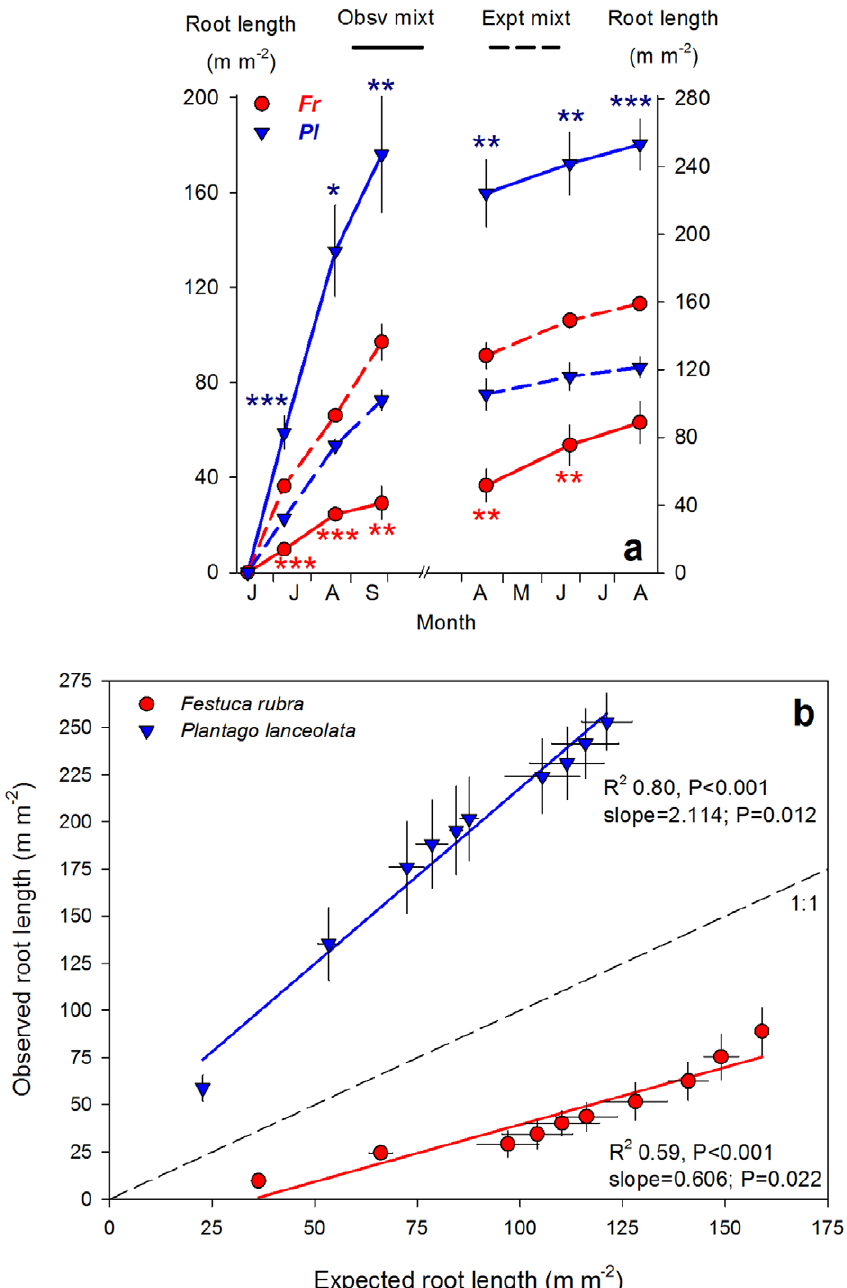
Figure 4. Root growth observed through minirhizotron tubes. ( a ) Root length production over time (m m 2 2 image) of Festuca rubra ( Fr ) and Plantago lanceolata ( Pl ) in mixtures, obtained from minirhizotron observations at 10 cm depth. Solid lines are for observed values, dashed lines for expected values from monocultures ( K of monocultures). On each date, t-test were run separately to detect significant differences between observed and expected values in each species. P -values were then adjusted using the Sidak correction for multiple comparisons. After correction, * P , 0.009; ** P , 0.002; *** P , 0.001. ( b ) Linear regression of expected versus observed root length of Plantago and Festuca in mixtures over the whole experiment, and null expectation expected=observed (1:1). Significance of deviation of slopes from unity is shown by p-values. Data are means 6 SE, N=3–4.